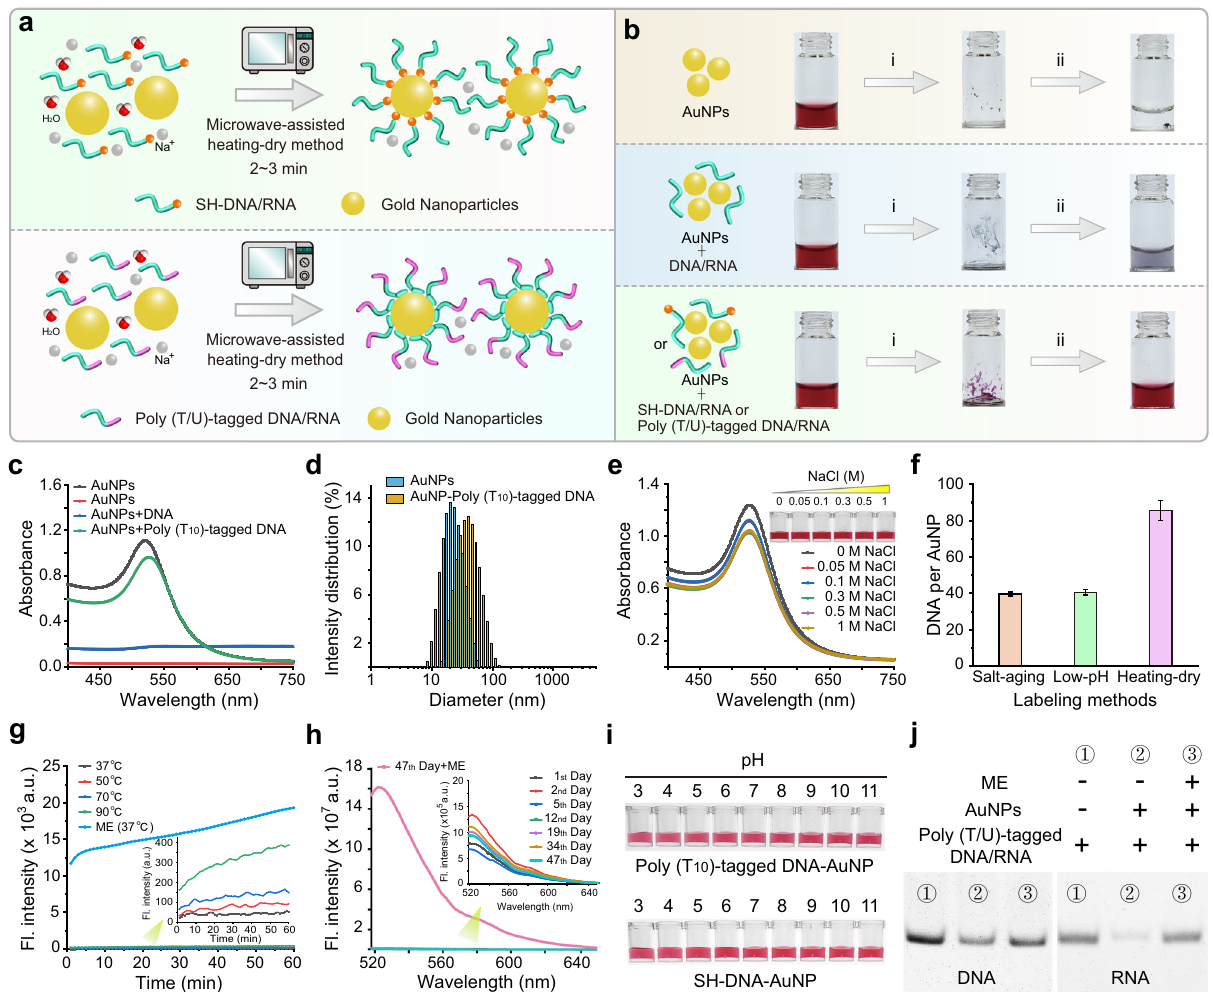
Fig. 1 Fast construction of DNA/RNA-AuNP conjugates based on MW-assisted heating-dry method. a Scheme of attaching thiolated and non-thiolated DNA/RNA to AuNPs using MW-assisted heating-dry method, in which the heating-dry process is driven by a domestic microwave oven for 2 – 3 min. b Photographs of AuNPs before and after heating-dry process. The bare AuNPs and random DNA/RNA sequence mixed AuNPs aggregated after heating dry treatment. While poly (T/U)-tagged DNA-AuNP retained monodispersed and seems red after heating dry and resuspension. (i) MW-assisted heating dry; (ii) resuspending with water or buffer. c Characterization of the non-thiolated DNA/RNA-AuNPs conjugates based on MW-assisted heating-dry labeling method using UV-vis absorption spectroscopy. d Dynamic light scattering measurement of the hydrodynamic diameters of bare AuNPs and DNA- AuNP conjugates. e Photographs and absorption spectroscopy showing the stability evaluation of DNA-AuNP conjugates in different NaCl concentrations. f The measured number of DNA probes attached to each AuNP. The DNA-AuNP conjugates were constructed using poly (A)-based salt-aging and low-pH methods, and poly (T)-based MW-assisted heating-dry method, respectively. Error bars = standard deviation ( n = 3). g Thermal stability evaluation of DNA-AuNP conjugates. The process of DNA desorption from AuNPs was monitored by measuring the fl uorescence intensity of FAM on DNA probes at varied temperatures. a.u. arbitrary units. h Time stability evaluation of DNA-AuNP conjugates. The process of DNA dissociation from AuNPs was monitored by measuring the fl uorescence intensity of FAM on DNA probes at different storage times. a.u. arbitrary units. i pH stability evaluation of thiolated and non-thiolated DNA-AuNP conjugates. j Evaluation of the integrality of DNA/RNA strands by 10% polyacrylamide gel electrophoresis (PAGE). Lane 1, the DNA/RNA strands used for heating-dry labeling. Lane 2, the excessive unlabeled DNA/RNA strands in the supernatant solution after the heating-dry labeling process. Lane 3, the released DNA/RNA strands replaced by ME from the resulted DNA/RNA-AuNP